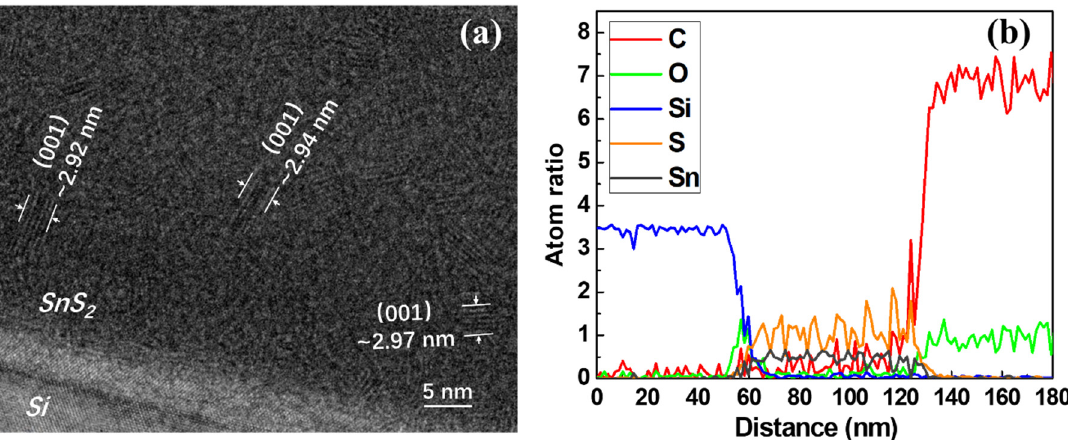
Figure 4. HRTEM image ( a ) and TEM-EDX line scanning profile ( b ) of the Sn x S y films deposited at 140 °C on the Si wafer.